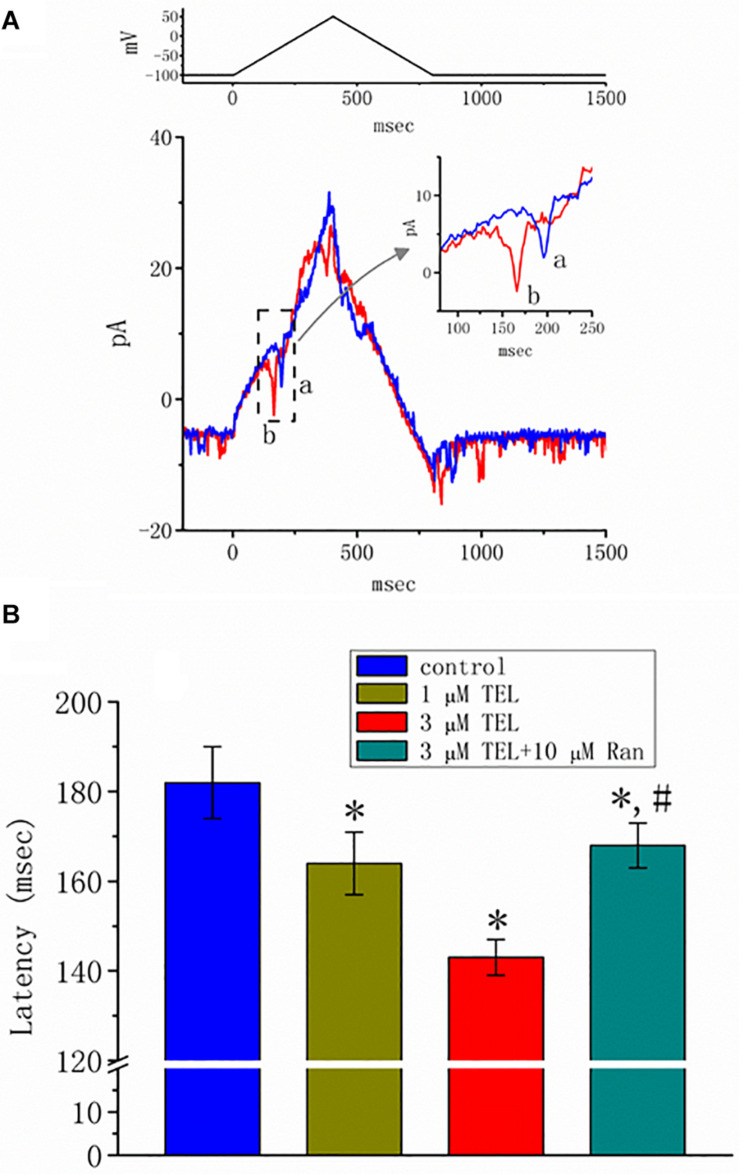
Effect of telmisartan (TEL) on action currents (ACs) in response to triangular voltage ramps. In these experiments, cell-attached current recordings were made of cells bathed in normal Tyrode’s solution containing 1.8 mM CaCl2. The potential was maintained at −100 mV so that, under cell-attached single-channel recordings, the membrane potential with respect to the resting potential was approximately + 30 mV. The triangular ramp pulses with a duration of 800 ms (indicated in the upper part of panel A) were delivered at a rate of 0.05 Hz. In (A), current traces in response to triangular voltage ramps, as indicated in the upper part of the figure, were obtained in the control (a) and during cell exposure to 3 μM TEL (b). The inset indicates expanded records of action currents (ACs), which correspond to the occurrence of APs (dashed box) and appear as a brief spike in a downward direction. Noticeably, a spike appears only in the up-sloping phase but not in the down-sloping one. (B) Summary of data showing the effects of TEL on the latency in the generation of action currents elicited by triangular voltage ramps (mean ± SEM; n = 6–9 for each bar). *Significantly different from control group (p < 0.05) and #significantly different from 3 μM TEL-alone group (p < 0.05).